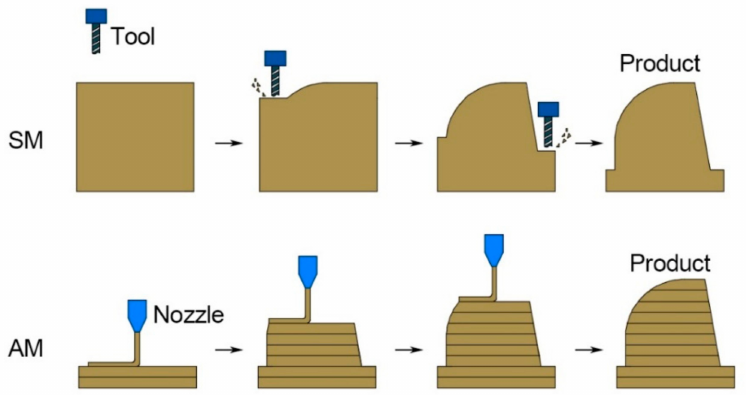
Figure 1. Subtractive manufacturing (SM) and additive manufacturing (AM).